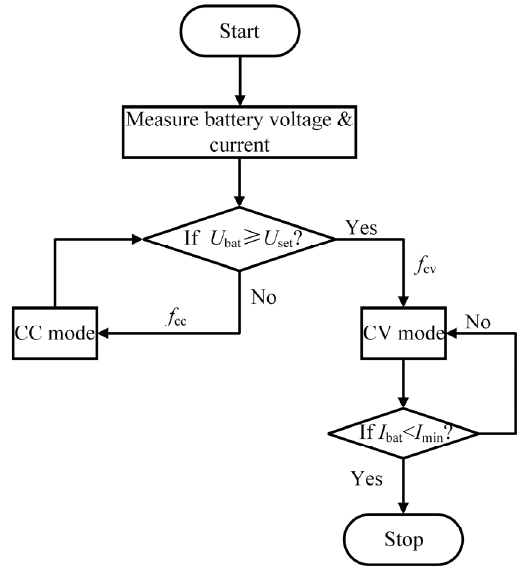
Figure 10. Program diagram for mode selection.